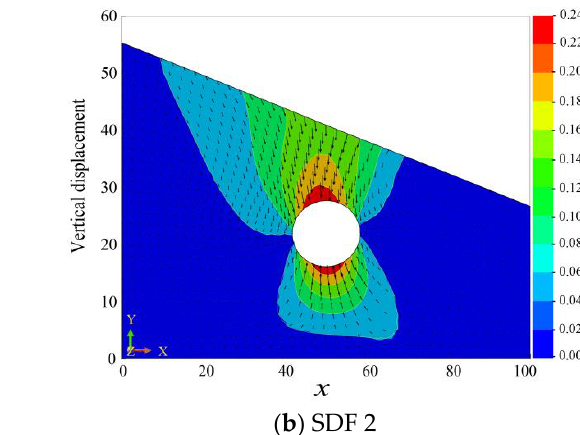
Figure 19 with a tilt angle β = 27 ◦ .